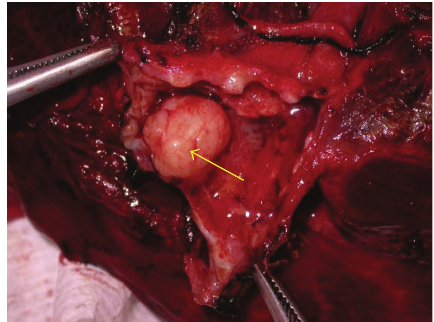
Figure 2: Gross, well-circumscribed endobronchial tumor.